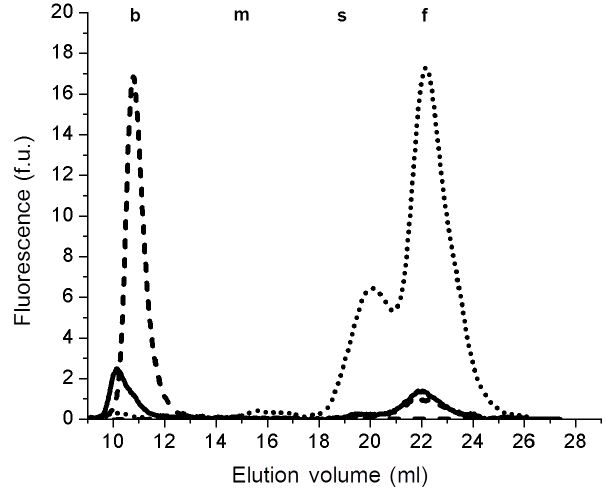
Figure 4. GGT activity of isolated microparticles and exosomes. GGT-specific elution profiles of isolated microparticles (continuous line), exosomes (dashed line) and microparticles/exosomes-free plasma (dotted line) samples. Microparticles were obtained from plasma by centrifugation (10,000 g, 45 min, 4 u C) whereas exosomes were recovered by ultracentrifugation (100,000 g, 2 h, 4 u C) of the corre- sponding microvesicles-free supernatant. Representative chromato- grams of five independent experiments are reported.